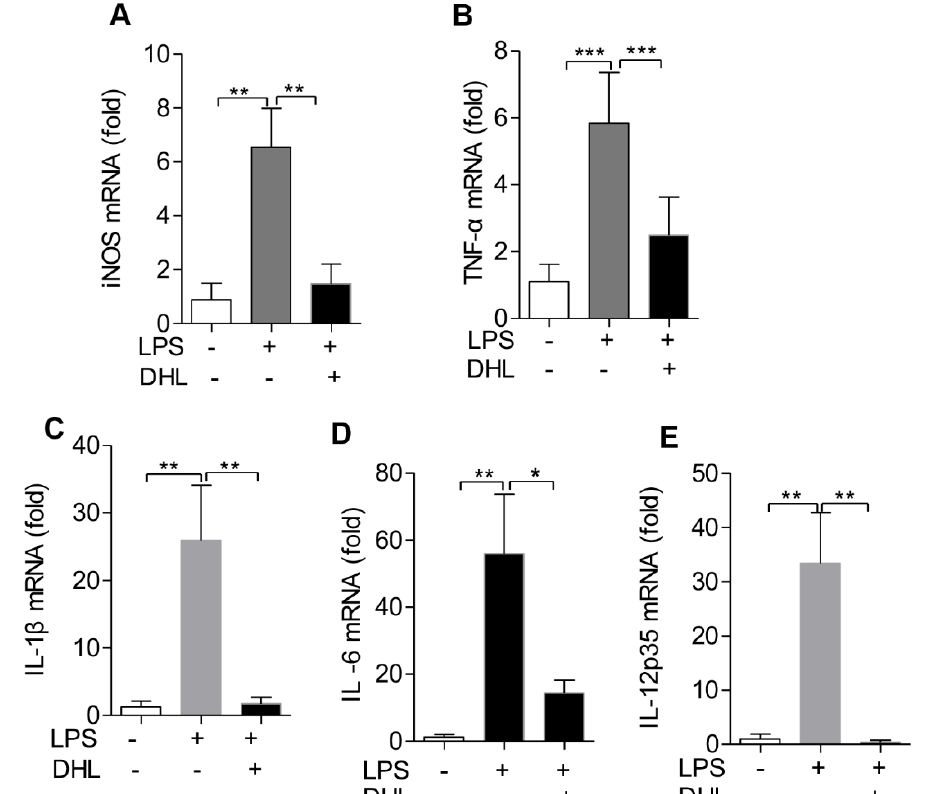
Figure 7. DHL decreased proinflammatory cytokines production in mice treated with LPS for 24 h. Mice were subjected to an intratracheal injection of LPS (5 mg / kg) and subsequent intraperitoneal injection of solvent or DHL (5 mg / kg), then mice were euthanized and the lung tissues were collected to isolate total RNAs. The mRNA expression level of ( A ) iNOS, ( B ) TNF- α , ( C ) IL-1 β , ( D ) IL-6 and ( E ) IL-12 p35 were measured by real-time PCR. Data represents means ± SEM, n = 6–8, * p < 0.05, ** p < 0.01 and *** p < 0.001.